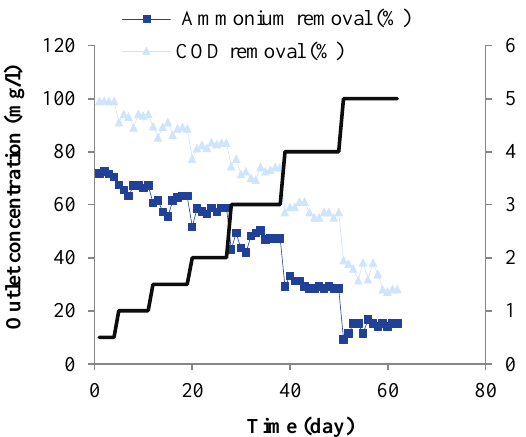
Figure 5. Variations in the effluent concentration of NO -N and nitrite accumulation rate (NAR) (%) 2 versus reaction time Effect of salinity on SND High saline wastewater induces salt stress in the microbial